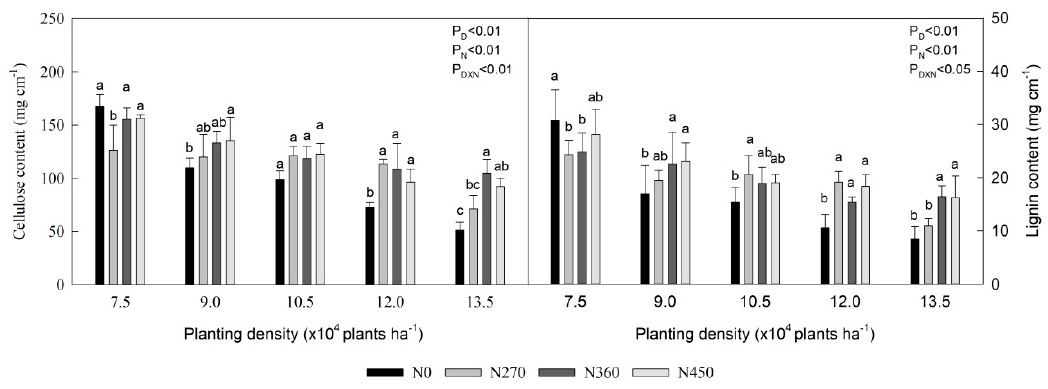
Figure 5. Effect of nitrogen application rate on the cellulose and lignin contents of the third basal internode of maize under drip irrigation at different planting densities (year 2018).